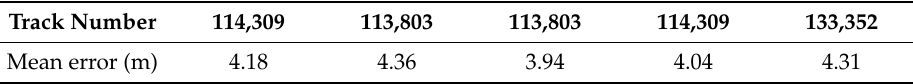
Table 4. Vertical track plane positioning accuracy results for five selected